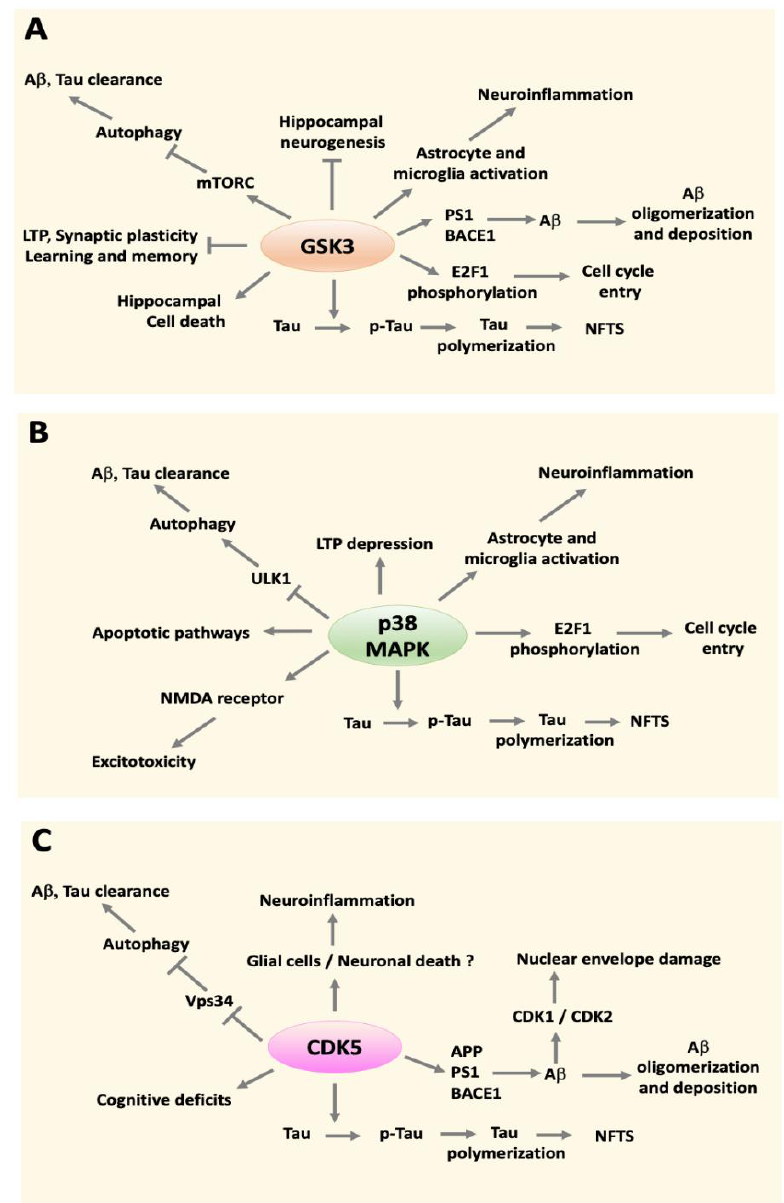
Figure 1. Effects of elevated GSK3, p38 MAPK and CDK5 activity in models of AD. ( A ) GSK3 increases A β levels